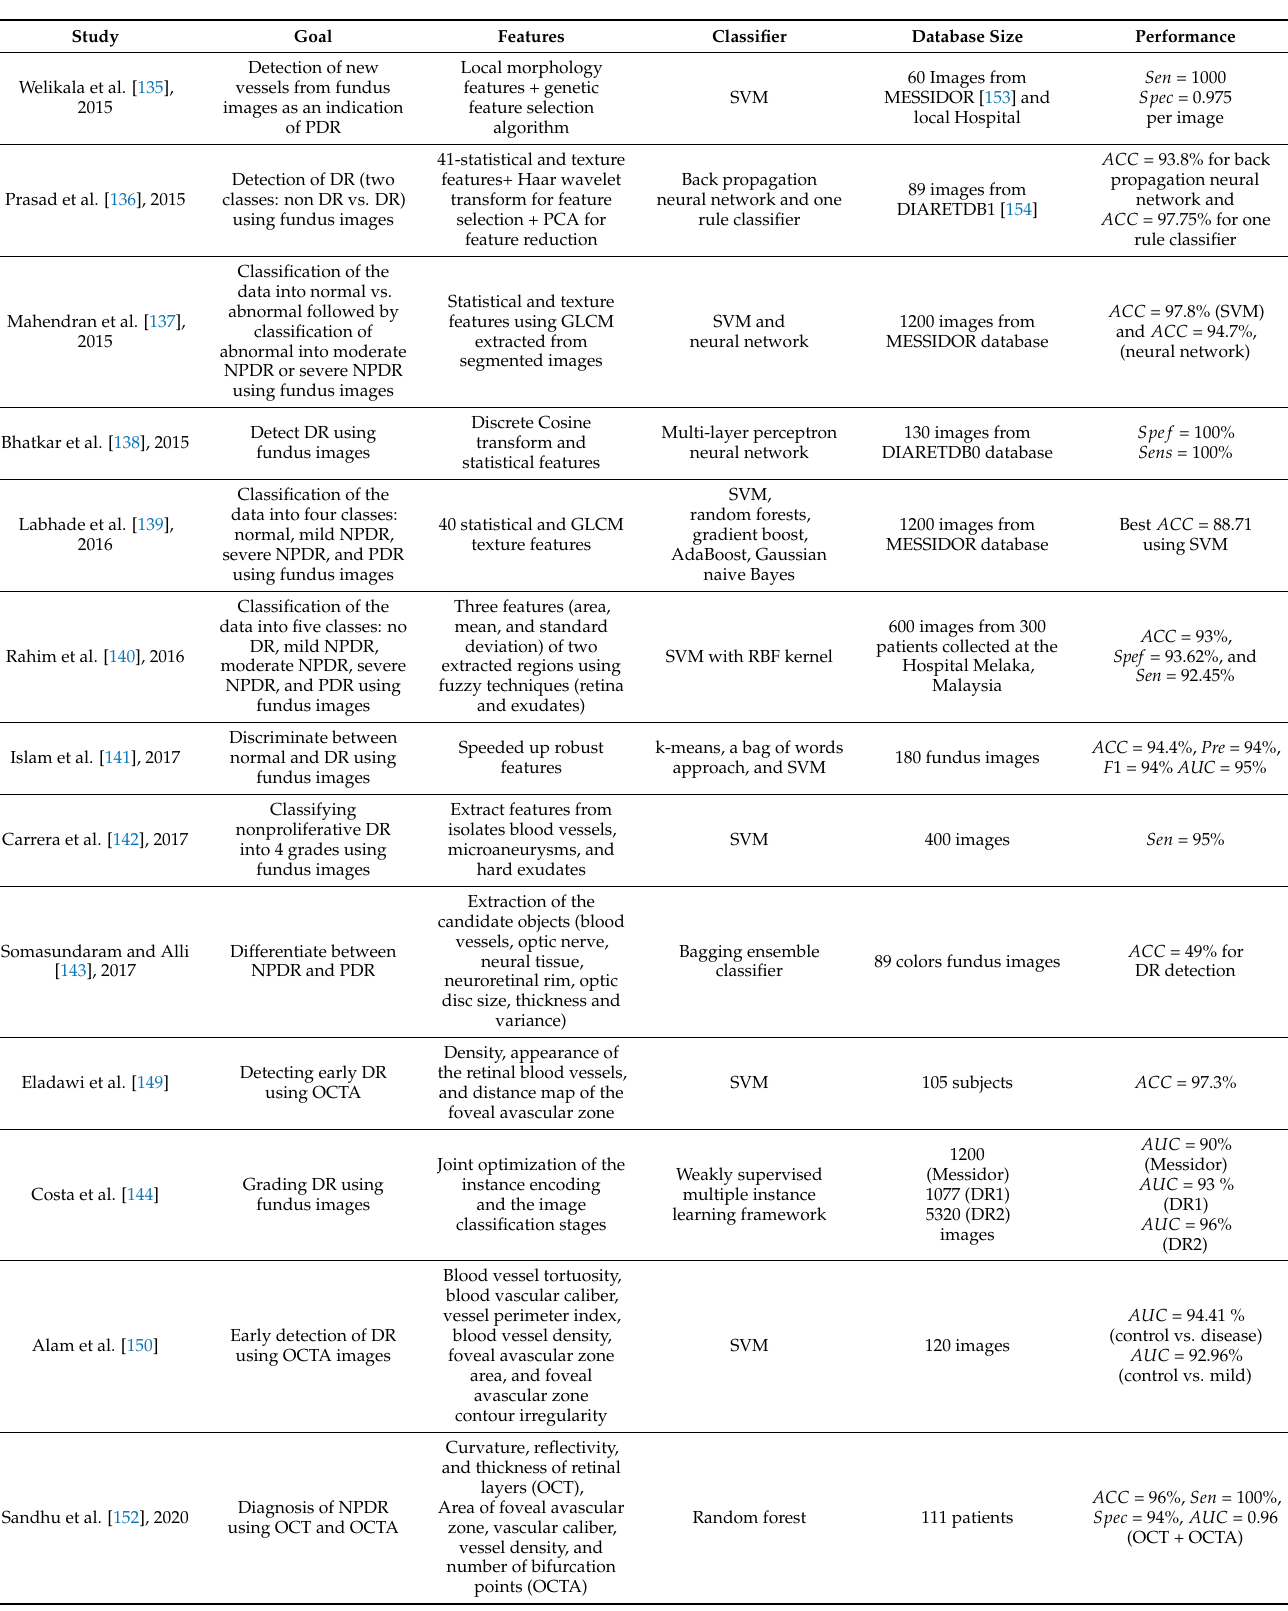
Table 1. Traditional ML methods for early detection, diagnosis, and grading of